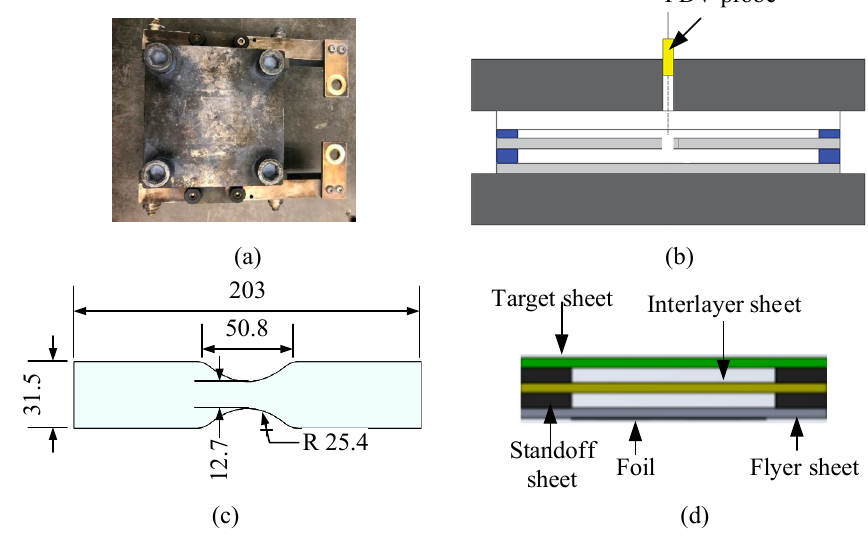
Figure 1. ( a ) actual implementation of the vaporizing foil actuator welding (VFAW) apparatus; ( b ) impact velocity test apparatus; ( c ) sketch of the aluminium foil; ( d ) schematic of the VFAW process.